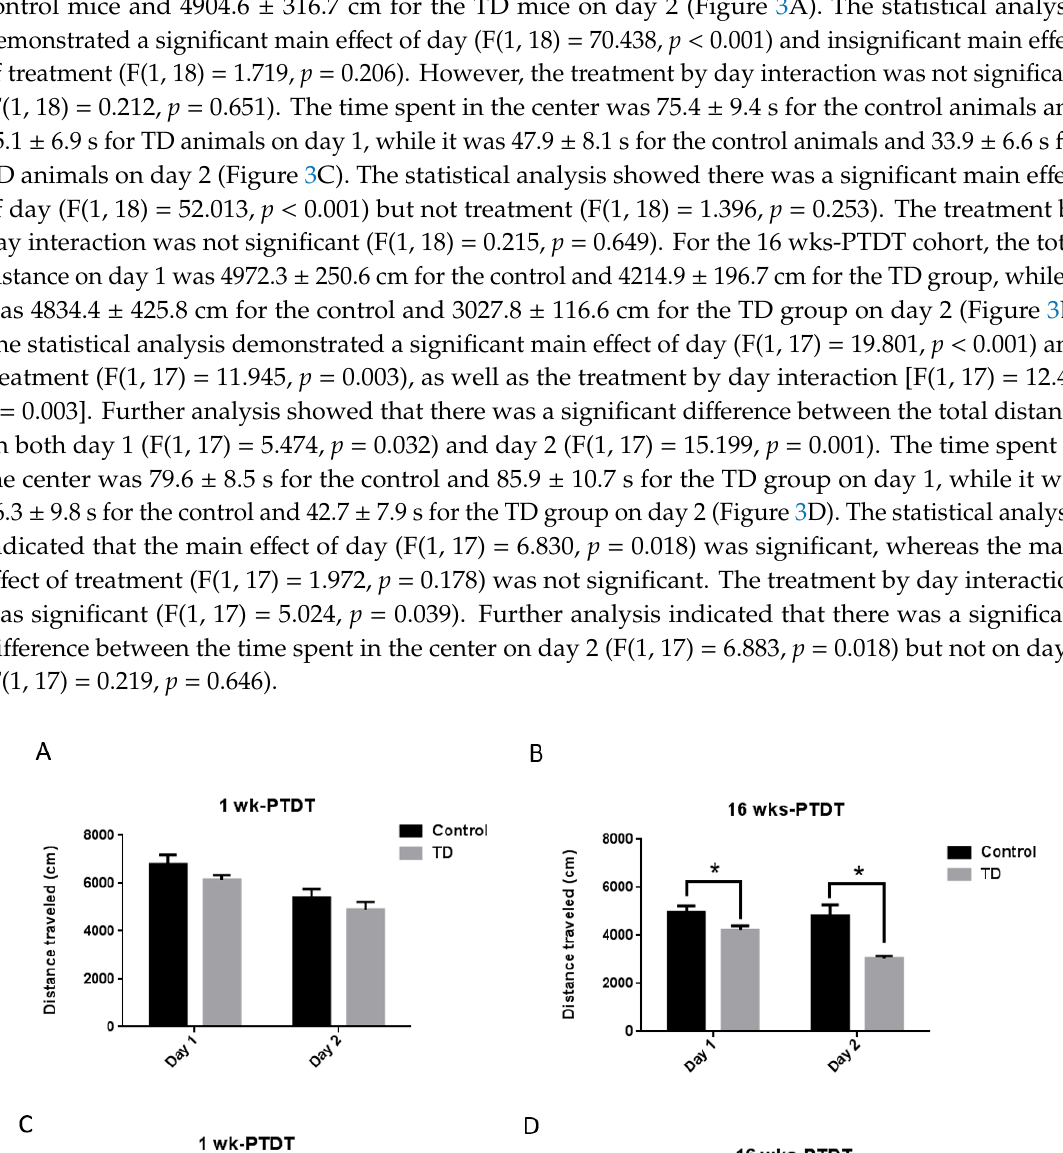
Figure 3. The results of the open field (OF) test of the two cohorts after TD treatment. The total distance travelled for two consecutive days was calculated for the 1 wk-PTDT cohort ( A ) and the 16 wks-PTDT cohort ( B ). The time spent in the center was also recorded for the 1 wk-PTDT cohort ( C ) and the 16 wks-PTDT cohort ( D ). For the 1 wk-PTDT cohort, n = 10 for both control and TD groups. For the 16 wks-PTDT cohort, n = 10 for the control group, and n = 9 for the TD group. * p < 0.05 denotes a statistically significant difference from the control group.